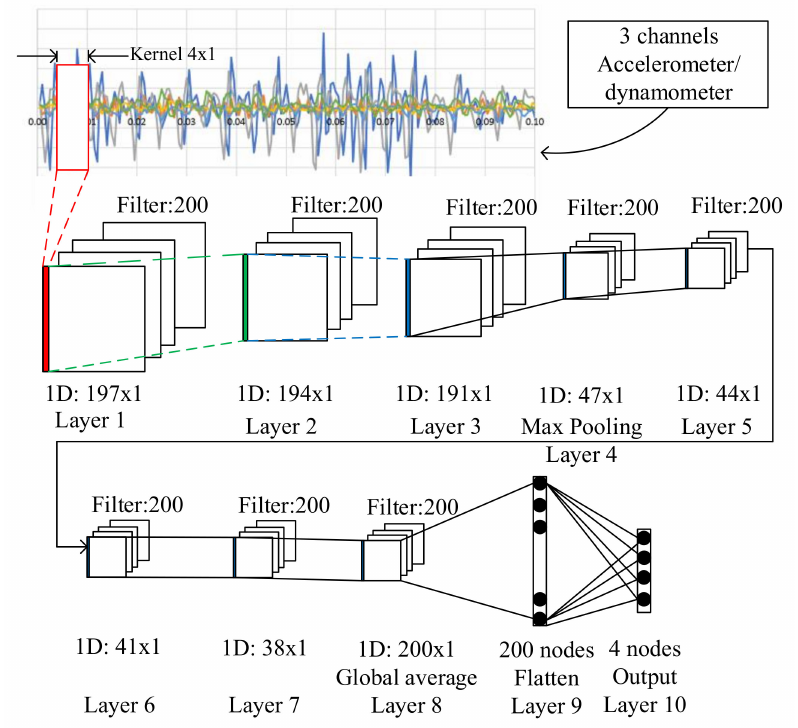
Figure 12. CNN model and architecture for 3-axis acceleration and 3-axis force data training and